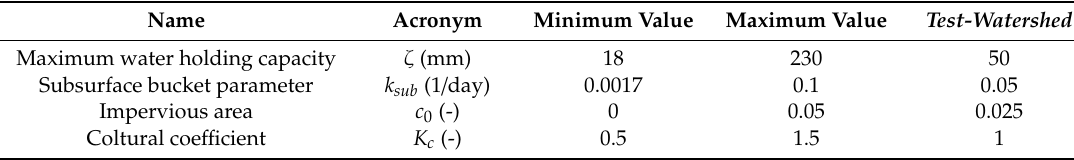
Table 2. The ranges for the morphological and vegetation parameters used in this work: minimum and maximum supposed values. In the last column, it is stated the value assumed referring to the test-watershed , used for leading our in-silico